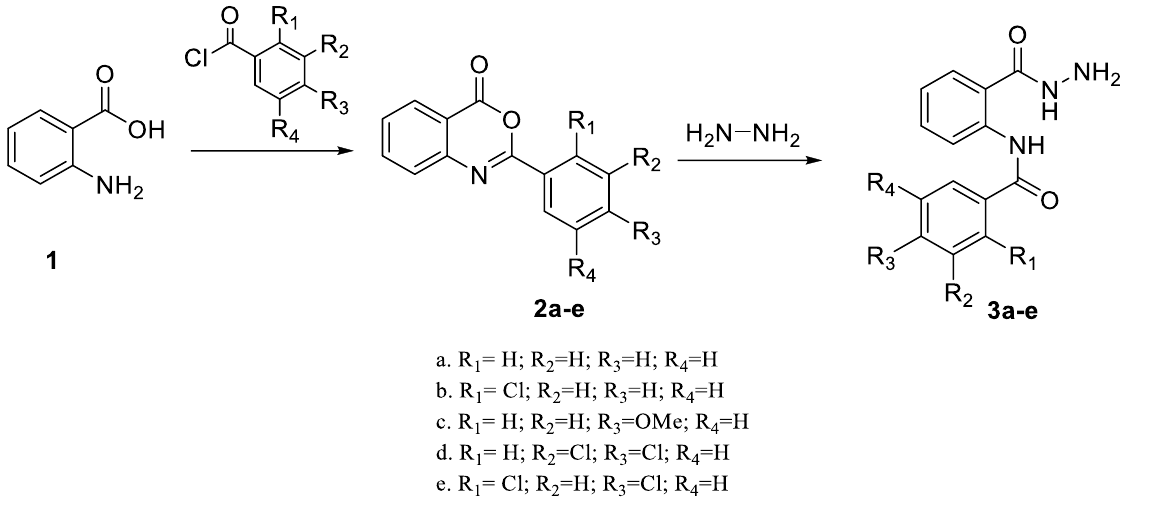
Figure 8. Synthesis of the title compounds.